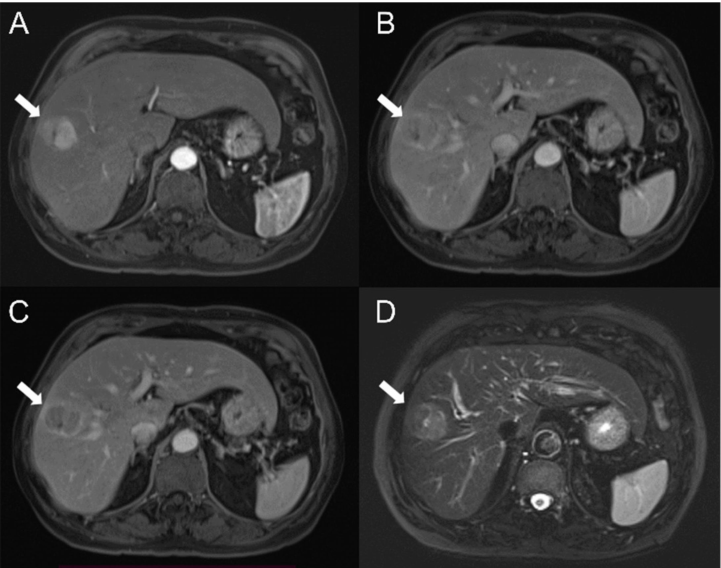
Figure 2. Well-differentiated hepatocellular carcinoma (HCC) (G1) in the right hepatic lobe of a 65-year-old white male. Results showed a hyperintense lesion on axial arterial phase ( A ) and the same lesion appeared hypointense on axial portal and tardive phases ( B , C ) and on fat-suppressed axial T2-weighted sequence ( D ) (white arrow).